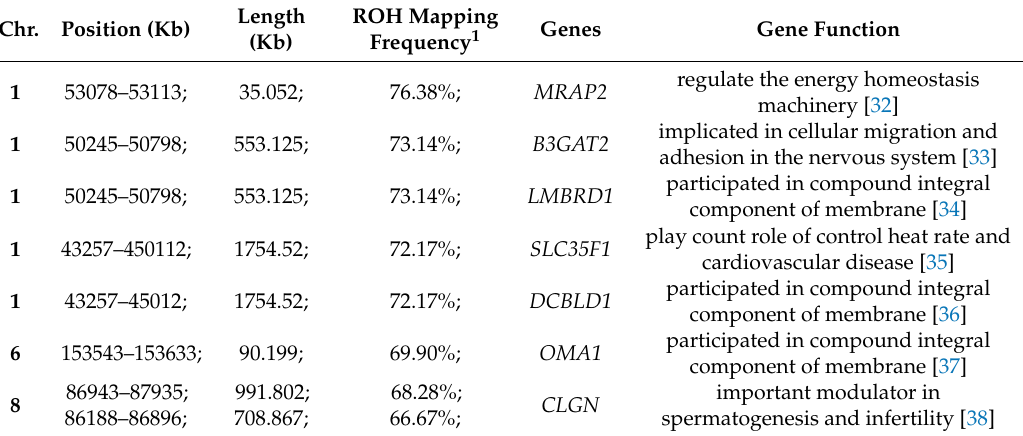
Table 3. A list of candidate genes overlapping with the core ROH regions in Pi é train pig. Chr. Position